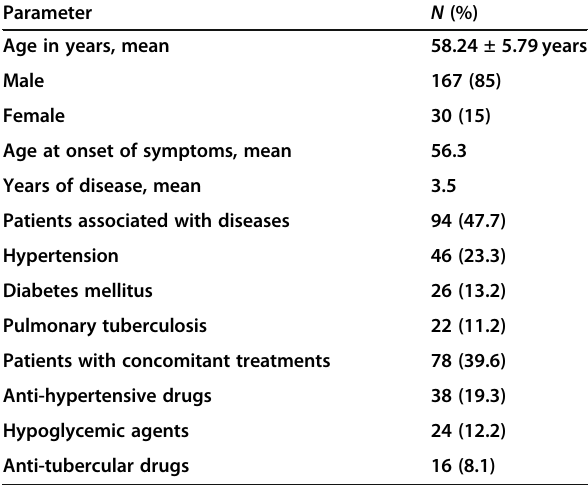
Table 2 Clinical profile of the